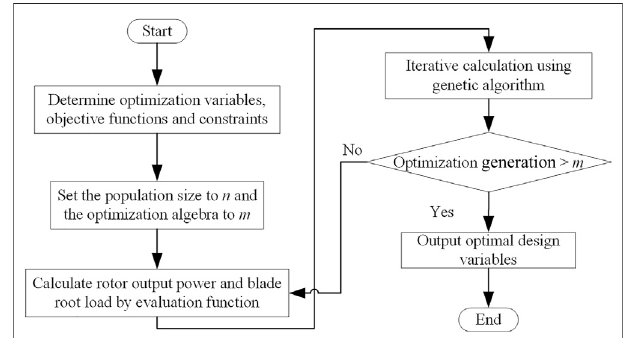
FIGURE 7 | The fl owchart of the proposed two-objective optimization design method.